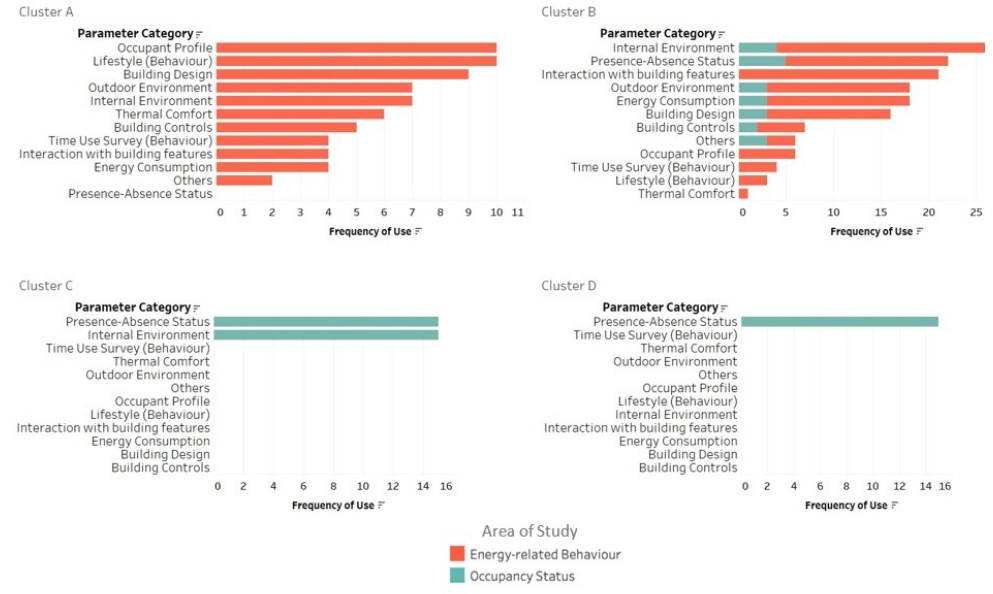
Figure 5. List of parameters used in different clusters along with their frequency of use. The techniques in cluster B frequently use parameters that explore the outdoor/in- door environment, presence or absence status, and the interaction of an occupant with the